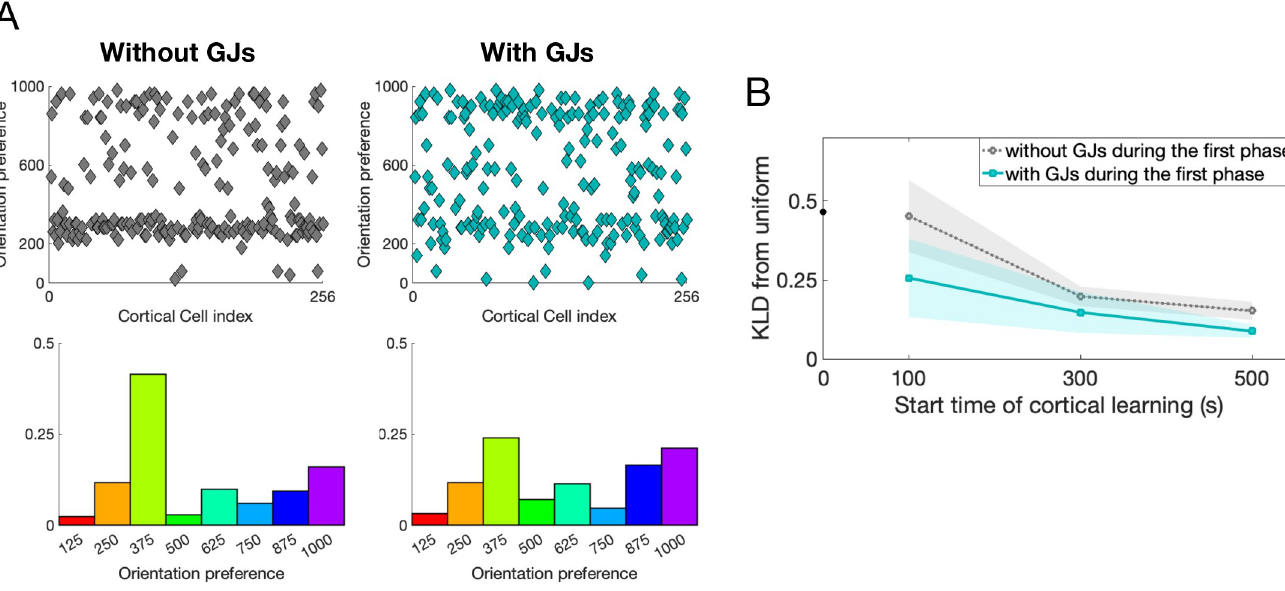
Fig 5. Distribution of OPs comparing a network containing GJ coupling to one without. A : (Top) Plot of each cell’s OP; (Bottom) distribution of OPs, for a network that does not contain (left) and one that does contain GJ coupling (right) during the first phase of development. The start time of cortical learning is 100 seconds. B : The average Kullback-Leibler divergence (KLD) between the uniform distribution and the OP distribution for the networks with (solid teal) and without (dotted gray) GJ coupling during the first phase. The curves are the average, and the shaded region the standard deviation, across 5 trials. Smaller values indicate distributions more similar to the uniform